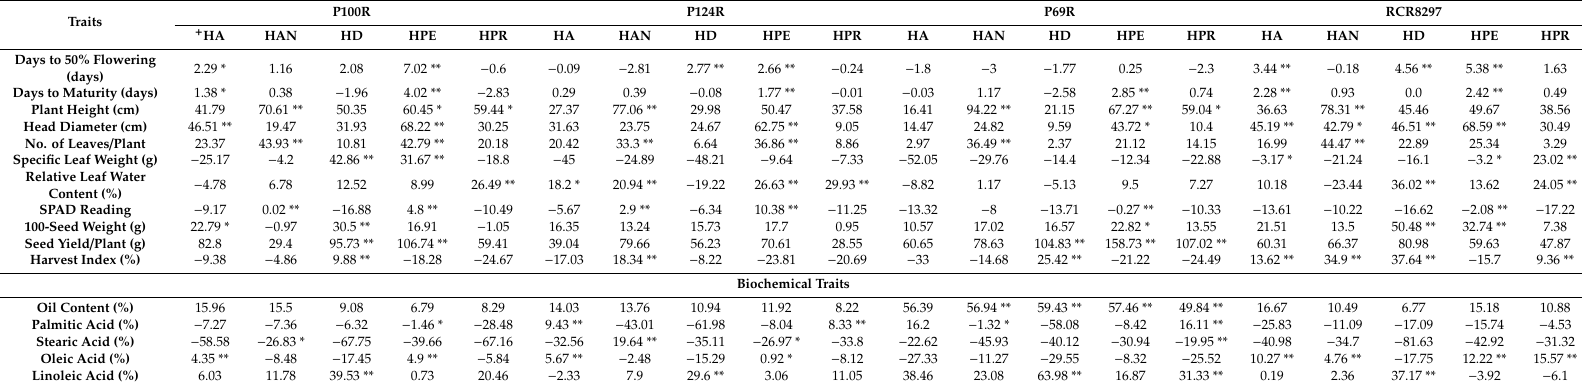
Table 4. Heterosis over mid-parent values (MPH, %) among CMS sources representing five di ff erent species of sunflower for morphophysiological, yield, and biochemical traits under the water stress